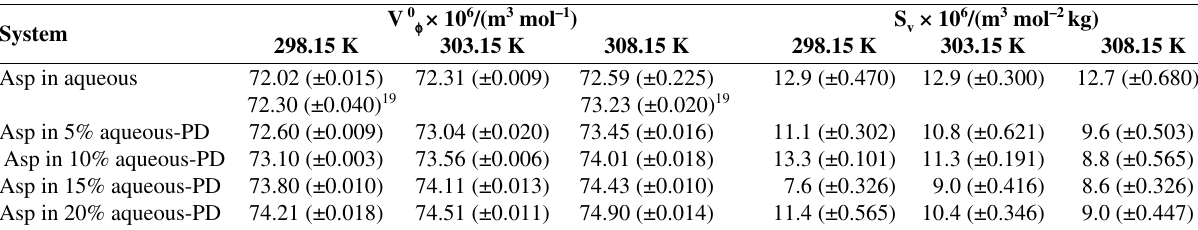
, and standard deviations of linear regression (in parenthesis) of Asp in v